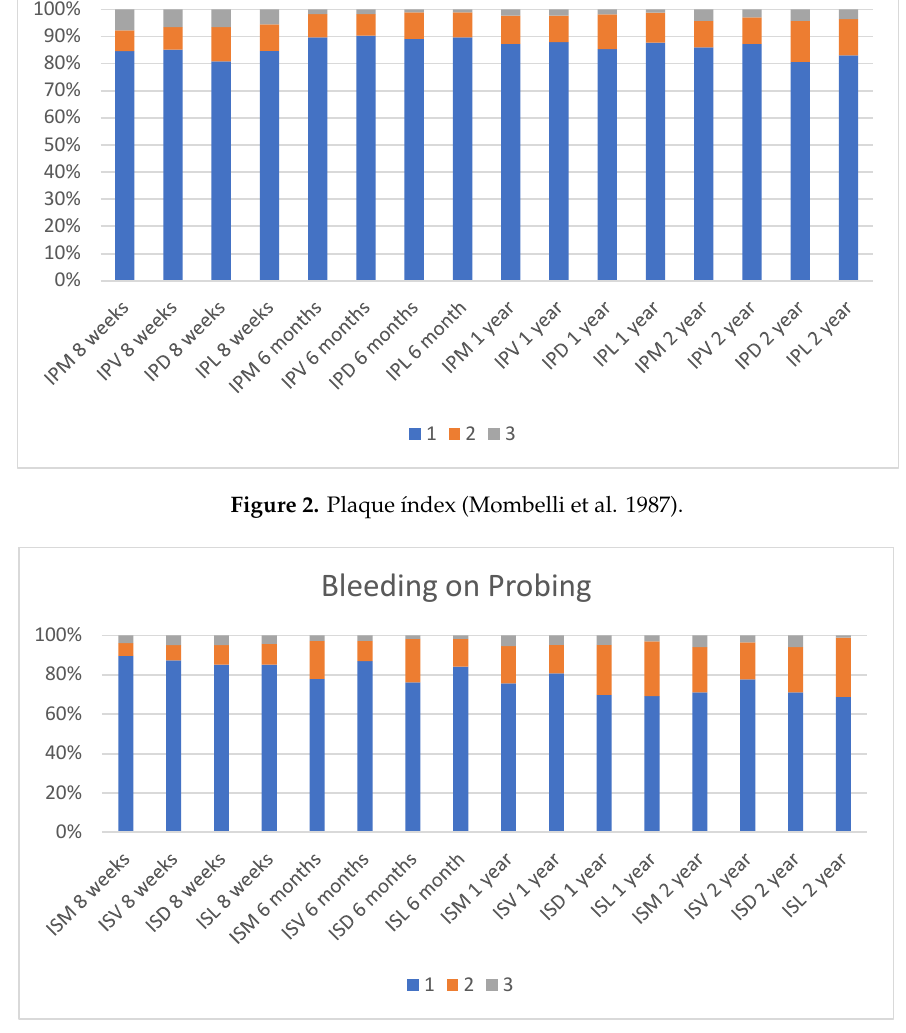
Figure 3. Bleeding on probing (Mombelli et al. 1987).